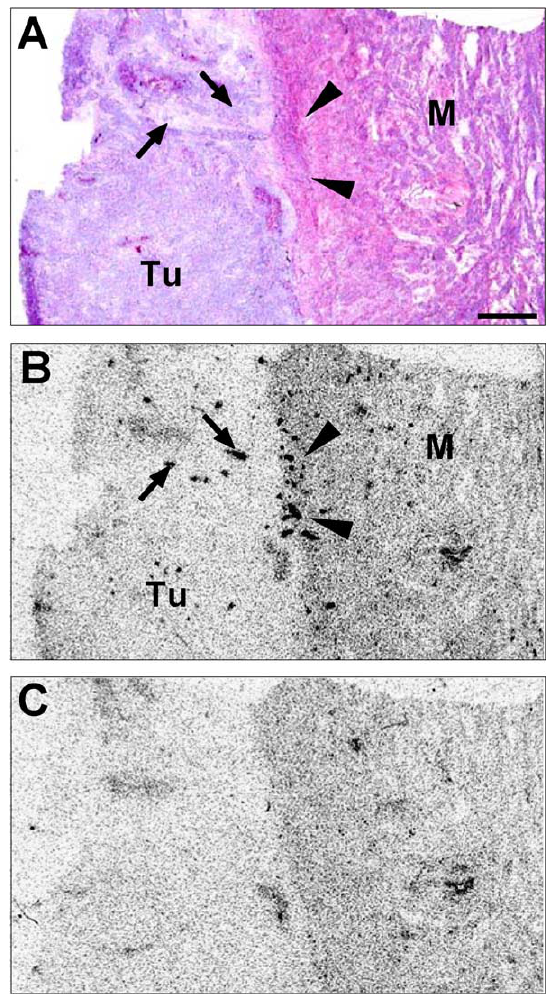
Fig. 4. GRP-receptor positive blood vessels are limited to the tumor tissue and the interface with the surrounding host tissue. A: H&E-stained section of a metastasis of a serous carcinoma (Tu) on the uterine surface adjacent to the myometrium (M); presence of blood vessels in the tumor (arrows) and the interface with the sur- rounding host tissue (arrowheads); bar = 1 mm. B: autoradiogram showing total binding of 125 I-[Tyr 4 ]-bombesin. Only vessels in the tumor (arrows) and the interface (arrowheads) are labeled, whereas deeper located myometrium vessels are negative; the myometrium (M) is weakly labeled, the neoplastic cells of the tumor (Tu) are not. C: control section showing non-specific